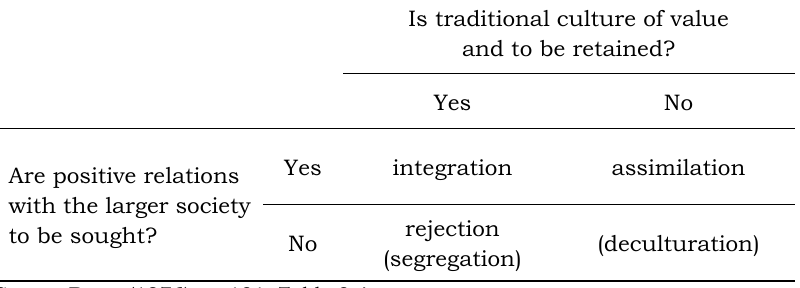
Table 2. Two major questions confronting acculturating communities Is traditional culture of value and to be